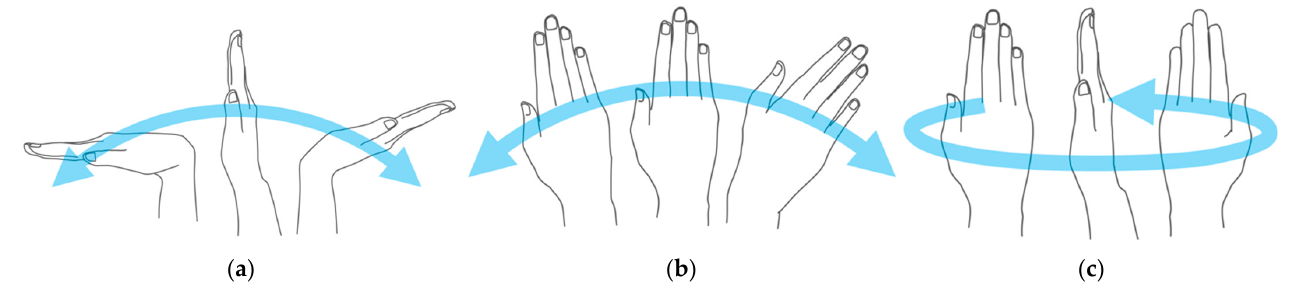
Figure 1. Located wrist positions assessment items options in RULA and REBA: ( a ) locate wrist position; ( b ) lateral deviation; and ( c ) twisted. position; ( b ) lateral deviation; and ( c )